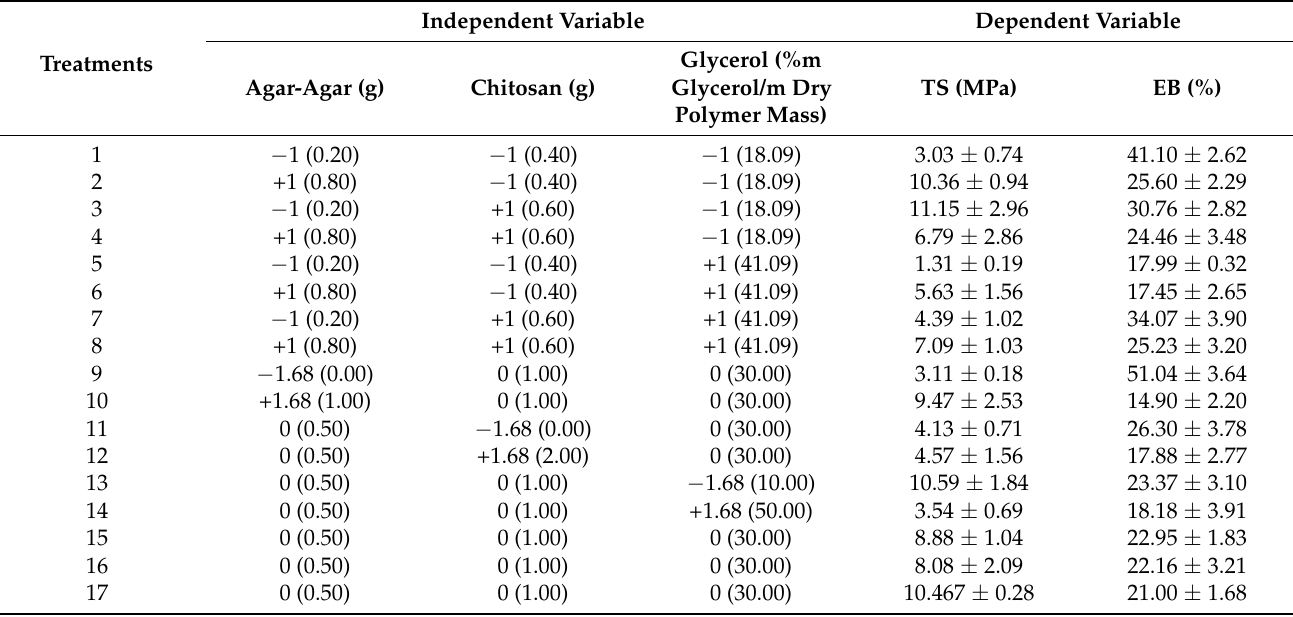
Table 2. Matrix of the central composite rotational design (CCRD) (coded and real